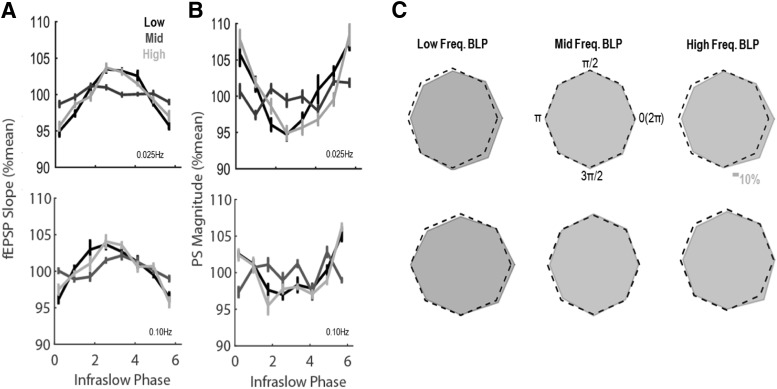
fEPSP slope (A) and PS amplitude (B) vary as a function of the phase of infraslow fluctuations in low- and high-frequency BLP but are not significantly altered by infraslow changes in middle-frequency BLP. C, The opposing effects of infraslow BLP phase on fEPSP slope and PS amplitude produce variations in EPSP-PS coupling across infraslow cycles in rats stimulated at either 0.25 Hz (top row) or 0.10 Hz (bottom row). Dotted lines depict unitary EPSP-PS coupling at all phases, and gray regions depict observed coupling (regions that exceed dotted lines indicate stronger EPSP-PS coupling than average, while regions that do not reach dotted lines indicate weaker EPSP-PS coupling). Scale bar represents a change of 10% of the mean EPSP-PS coupling.